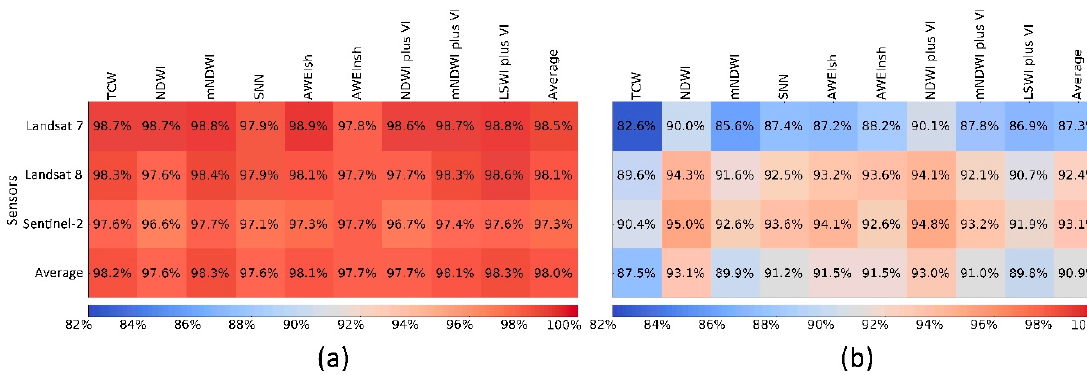
Figure 5. Producer accuracies ( a ) and user accuracies ( b ) of different combinations of the nine algorithms and the three sensors (Landsat 7 ETM+, Landsat 8 OLI, and Sentinel-2 MSI).